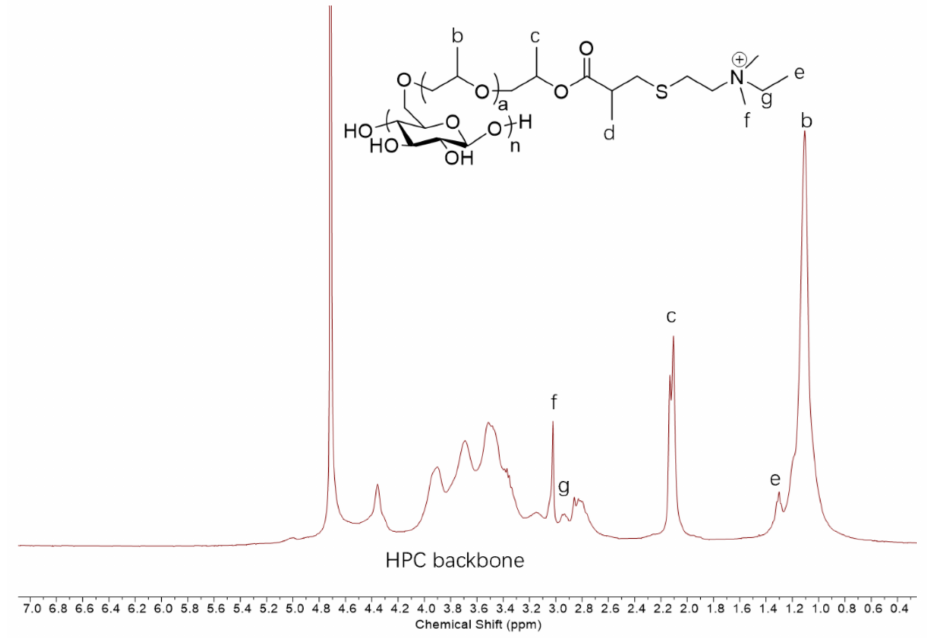
Figure 3. 1 H-NMR spectrum of